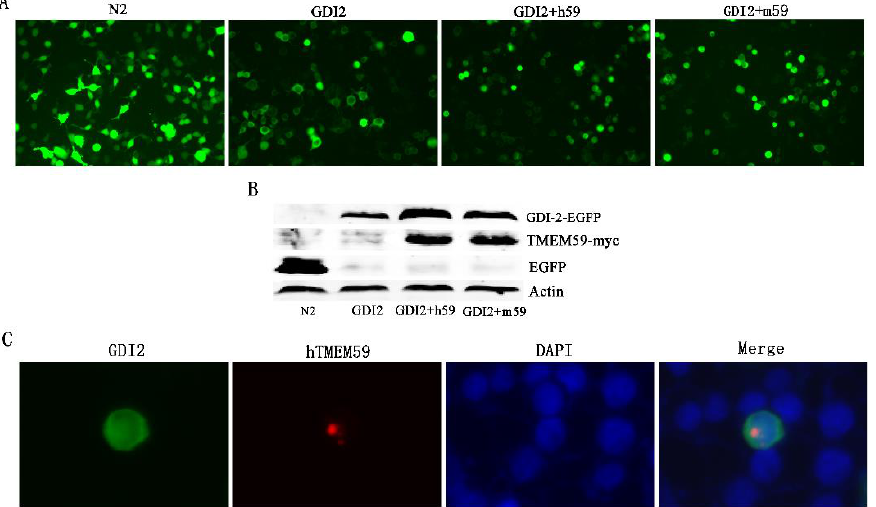
Figure 8. TMEM59 increases the protein amount of GDI2. ( A ) Overexpression of TMEM59 leads to retention of GDI2 in the cytoplasm. ( B ) TMEM59 increases the amount of GDI2 protein in HEK293T cells. Western blotting showed that overexpression of TMEM59 increases the expression of GDI2. ( C ) TMEM59 and GDI2 showed no obvious colocalization in the cytoplasm.